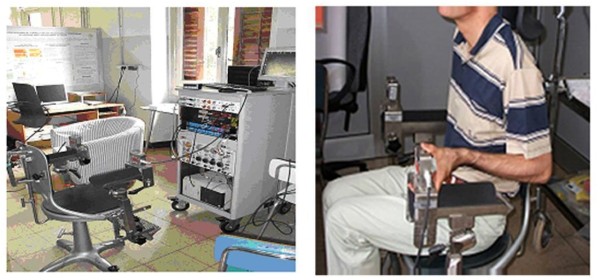
The load cell. Illustration of the load cell used for the hand grip muscle strength measurements used in the study.